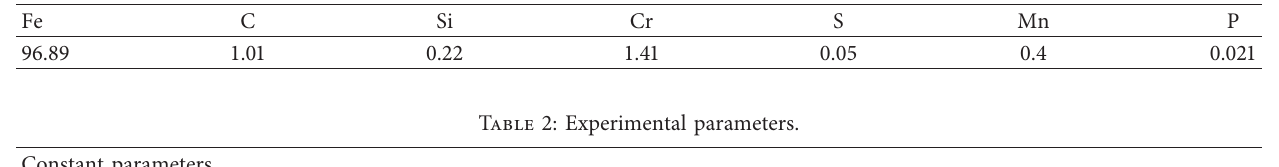
Table 1: Chemical composition of AISI 52100 steel.